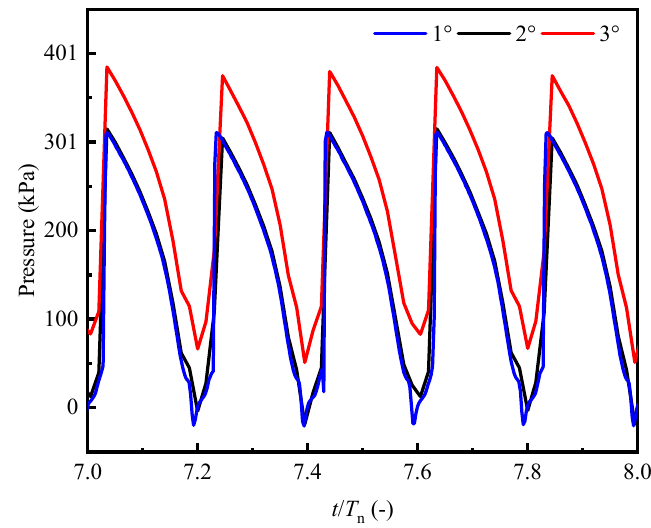
Figure 6. Time step independence verification.